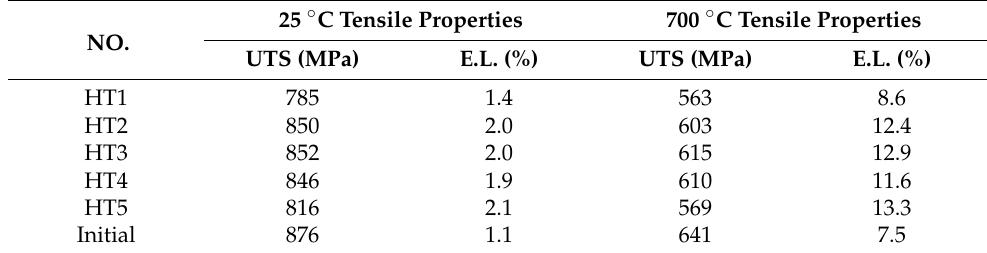
Figure 6. 25 °C and 700 °C tensile properties of initial and heat-treated composites: ( a ) 25 °C tensile properties and ( b ) 700 °C tensile properties.